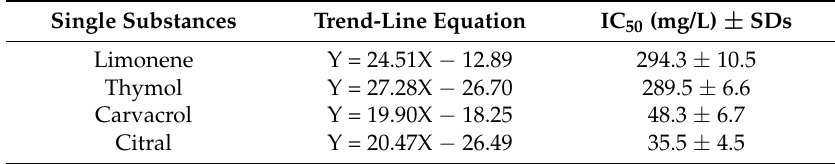
Table 2. Evaluation of cytotoxicity of main single constituents of oregano EO against HepG2 cells. Single Substances Trend-Line